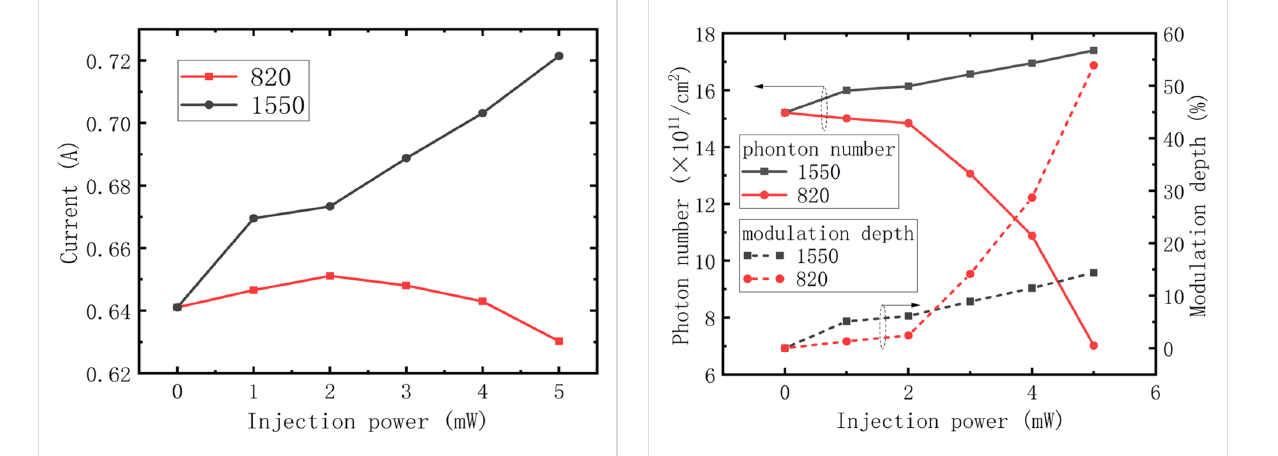
creases the temperature of the electrons, which enhances the backfilling effect and blocks the transition of electrons. Before